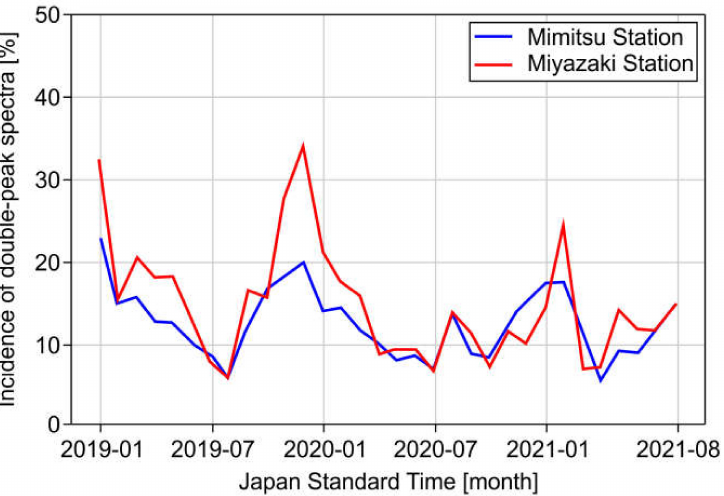
Figure 5. Monthly incidence of double-peak spectra over the entire observation area. Vertical axis is incidence of double-peak spectra. The horizontal axis is the monthly change from January 2019 to August 2021. Red and blue lines indicate the incidence of double-peak spectra for each month at the Mimitsu and Miyazaki stations,